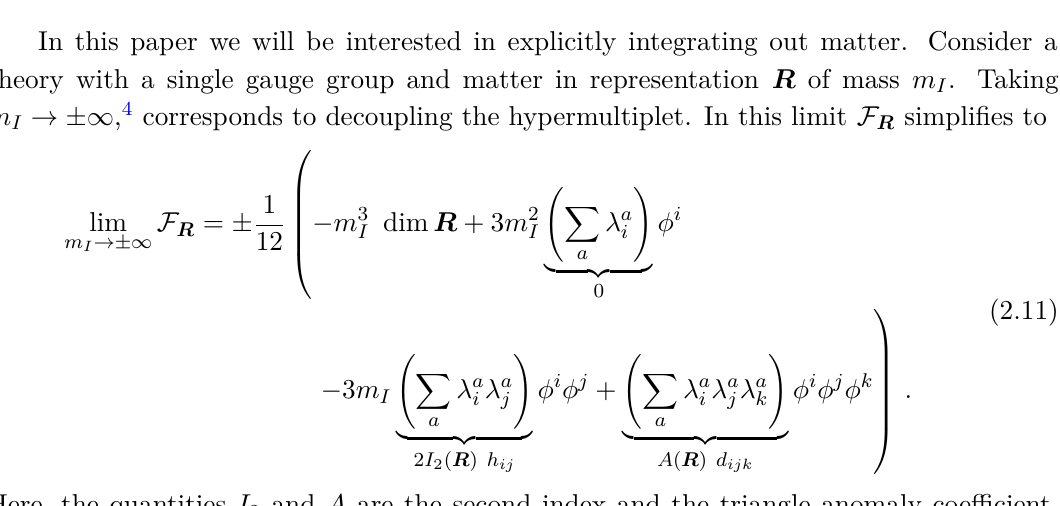
Table 3 . Second index and triangle anomaly coefficient for various representations of G